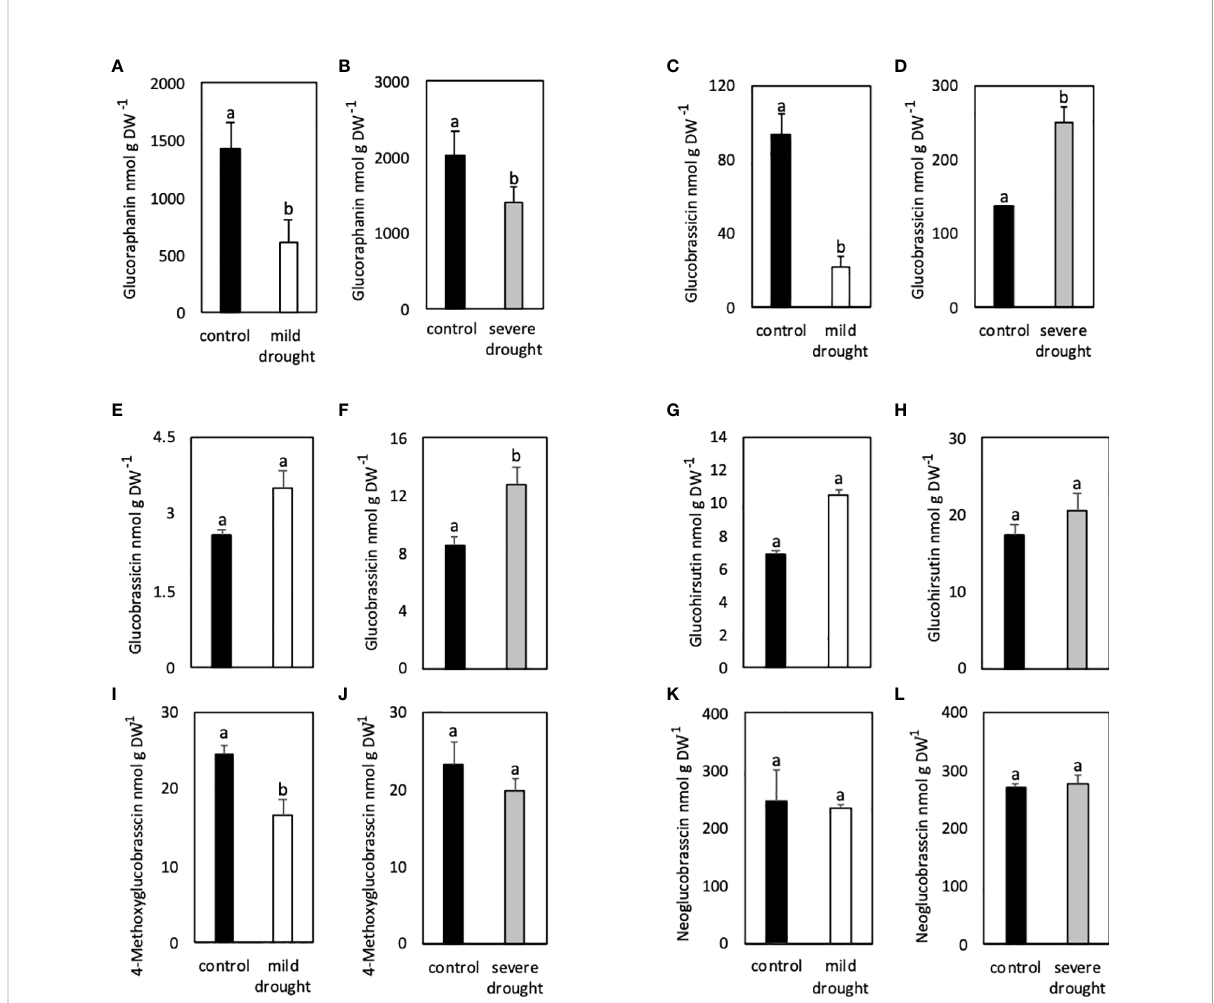
FIGURE 2 Glucosinolate contents in leaves (A – D) and roots (E – L) of mildly (white bars) and severely (grey bars) drought-stressed Arabidopsis thaliana Col- 0 plants subjected to 20% and 40% PEG 20,000, respectively, for 7 days. Plants were grown on petri dishes for fi ve weeks prior to application of drought stress. Bars represent means of three biological replicates consisting of four pooled plants each. Different letters indicate signi fi cant differences (p<0.05) between control and drought-stressed